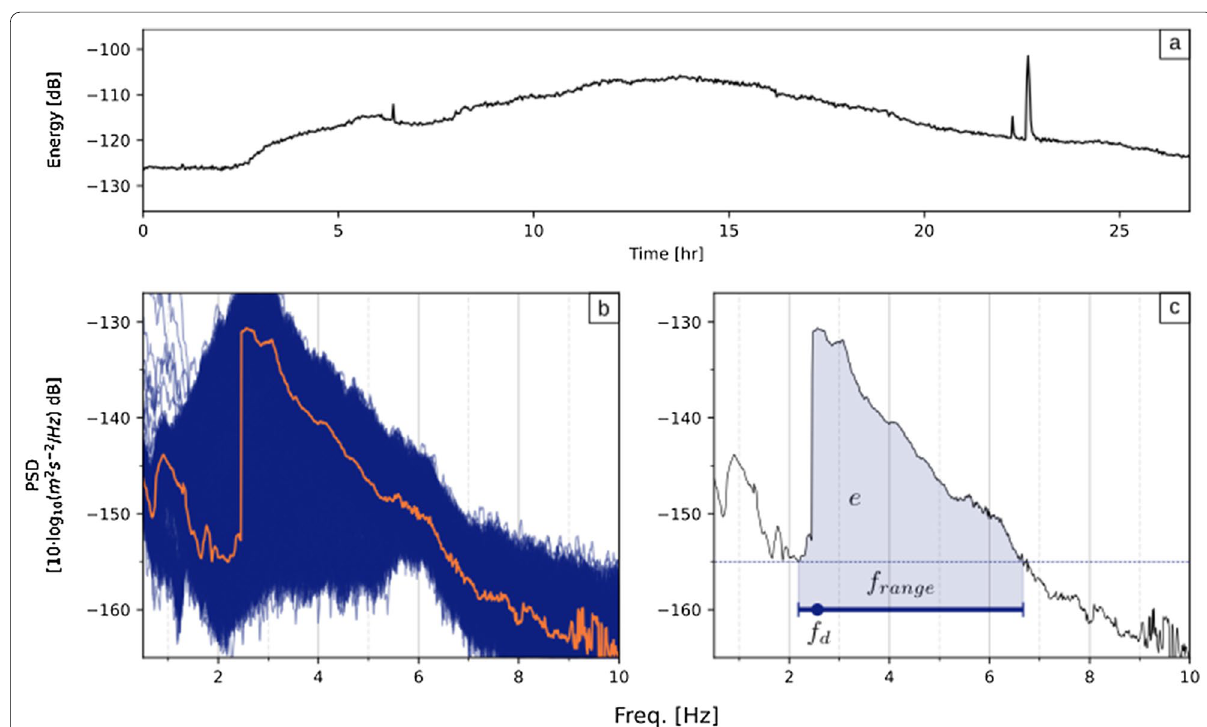
Fig. 8 The broad-band tremor occurred at 09:20:00 UTC on 1 June 2012. a Time evolution of the energy in the range 0.5–10 Hz. b The 1608 1-min PSD composing the episode along with the most probable PSD (pPSD), in orange. c Schematic representation of the measures of dominant frequency f d , frequency range f range , and energy